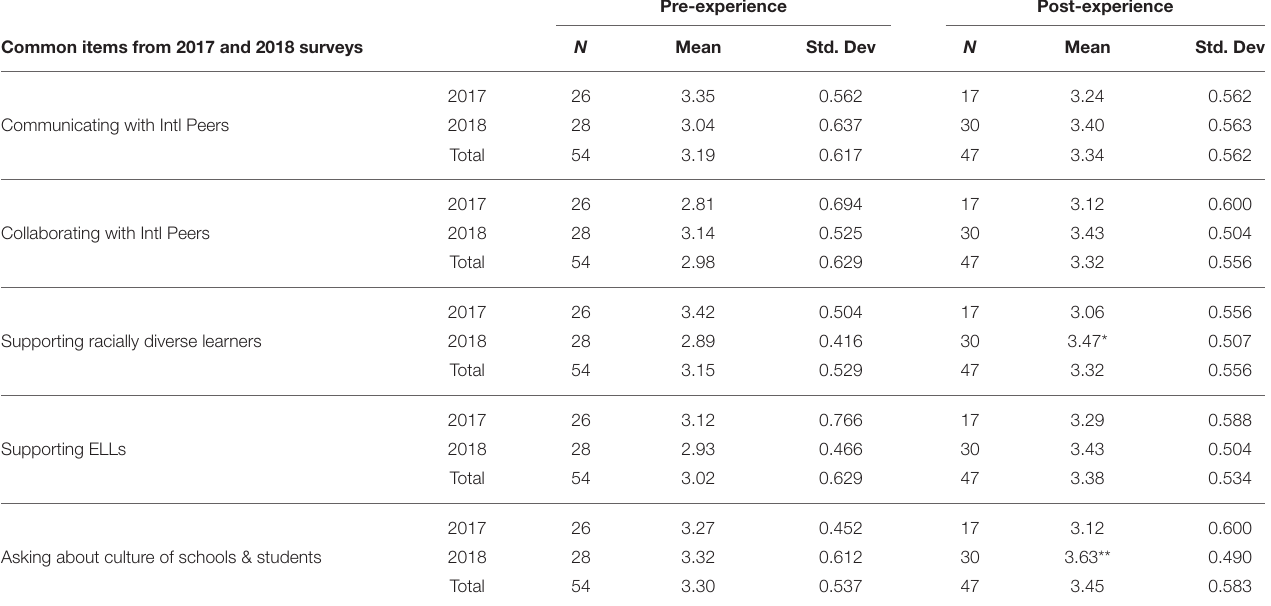
TABLE 1 | Pre-experience and Post-experience self-efficacy, Year 2 vs. Year 3.